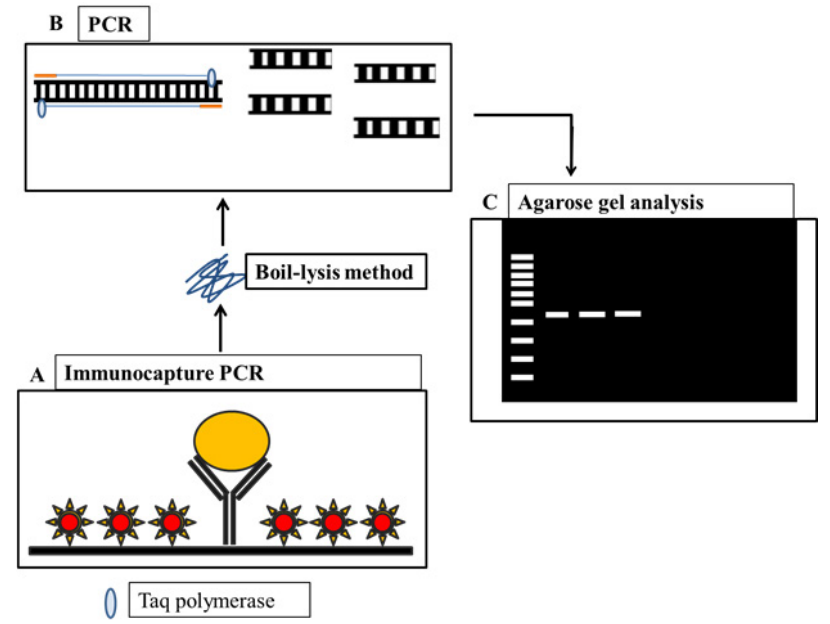
Fig. 3. Schematic representation of IC-PCR and PCR-ELISA employed in the present study